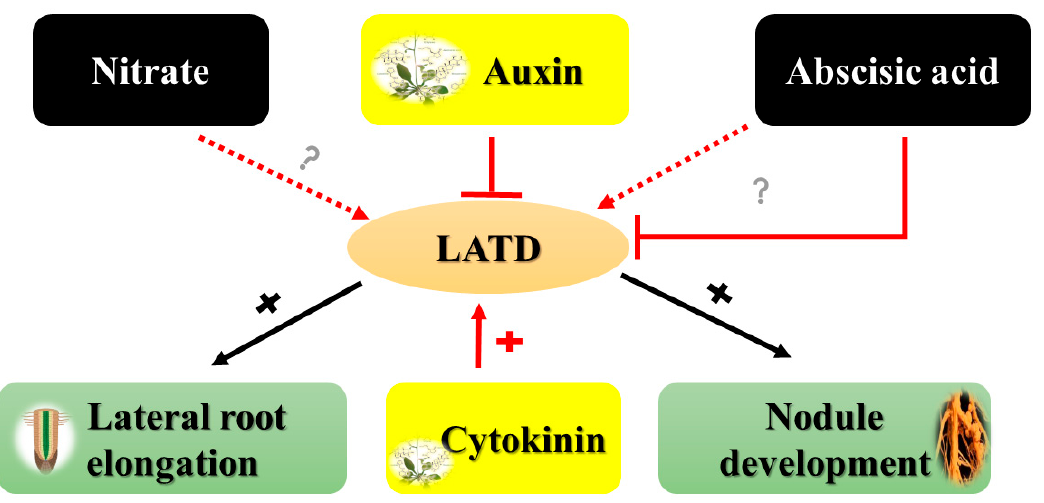
Figure 3. Review of LATD regulation, biochemical activity, and function. Black arrows indicate the involvement of LATD in nodule development and lateral root elongation. Red arrows and lines show up-regulation and down-regulation of LATD gene expression, respectively, by CK and AUX, and ABA. Dashed arrows indicate a proposed role of LATD (nitrate transport/ABA/another substance) (Adapted from